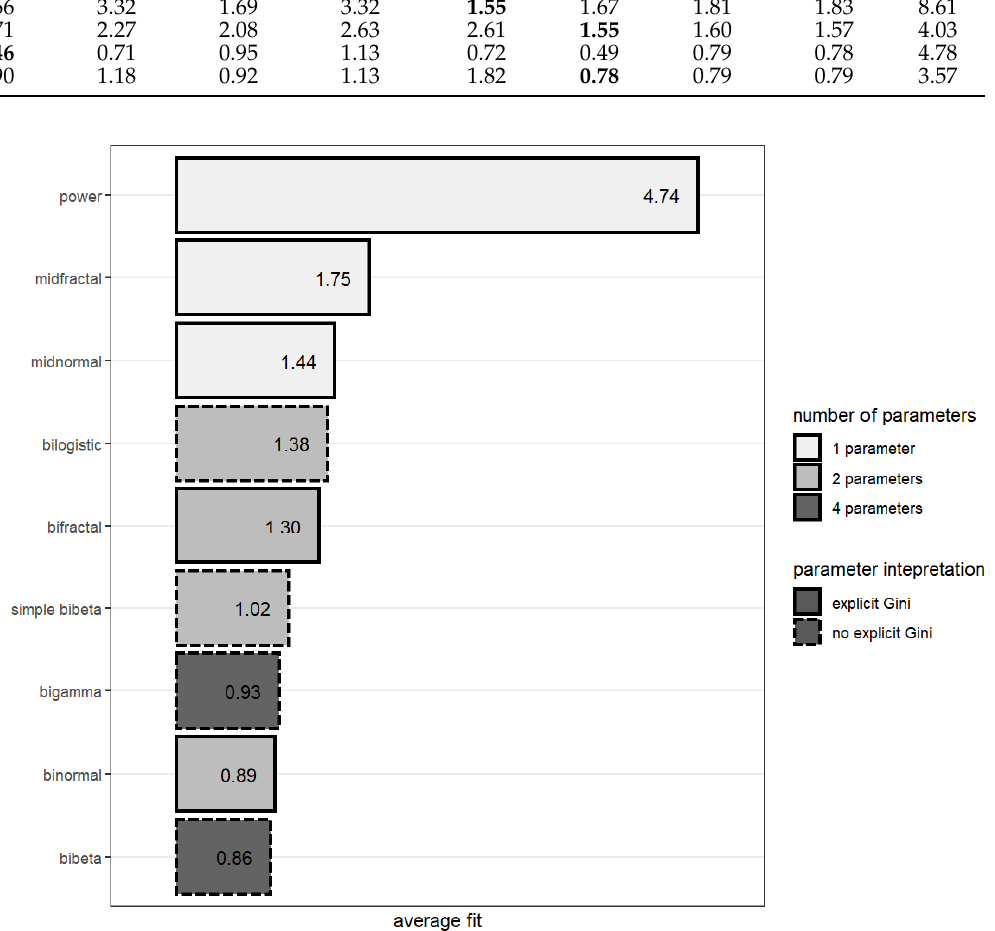
Figure 4. Average goodness of fit ( (cid:3493)𝑓 (cid:3042)(cid:3029)(cid:3037) × 100 ) for particular models.